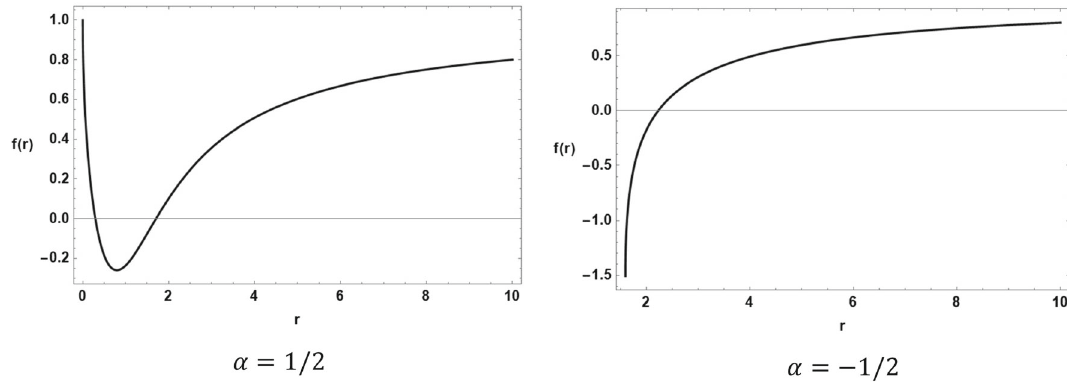
Fig. 1 The graph of the metric function f ( r ) with respect to r for two typical values of